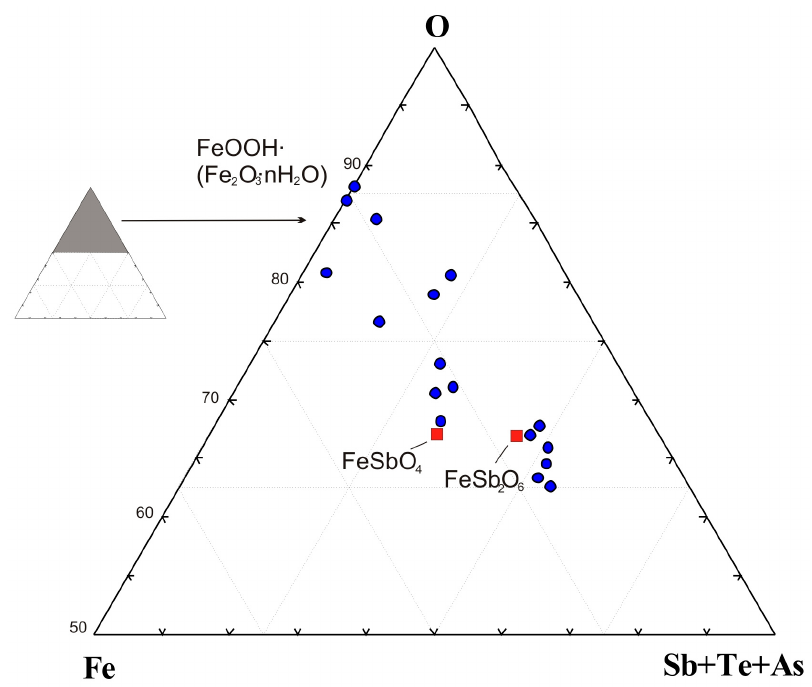
Figure 5. Ternary plot showing the composition of Fe–Sb–Te–As–Se–S-oxides localized in the pores of mustard gold, shown in the Figure 4 and Table 4. FeSbO 4 and FeSb 2 O 6 are tripuhyite [21]. The blue circles are analytical data, the red square is stoichiometric composition of minerals. Table 5. The mixed compositions of mustard gold and goethite/hydrogoethite (wt. %) as shown in Figure 6.